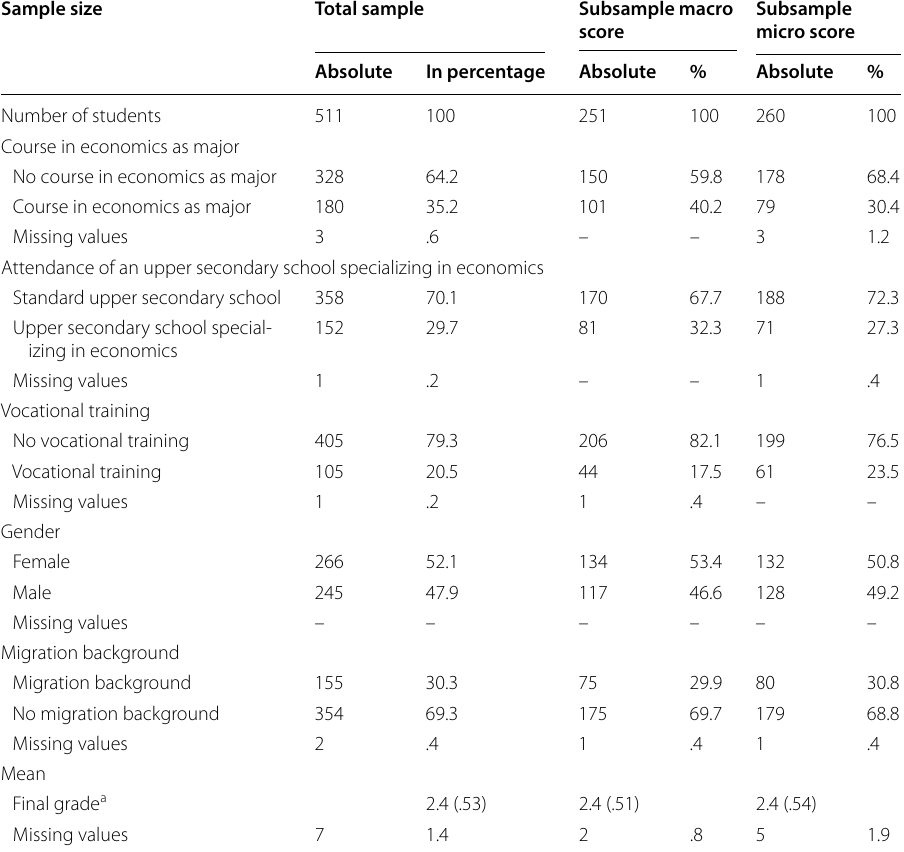
Table 1 Descriptive statistics of the